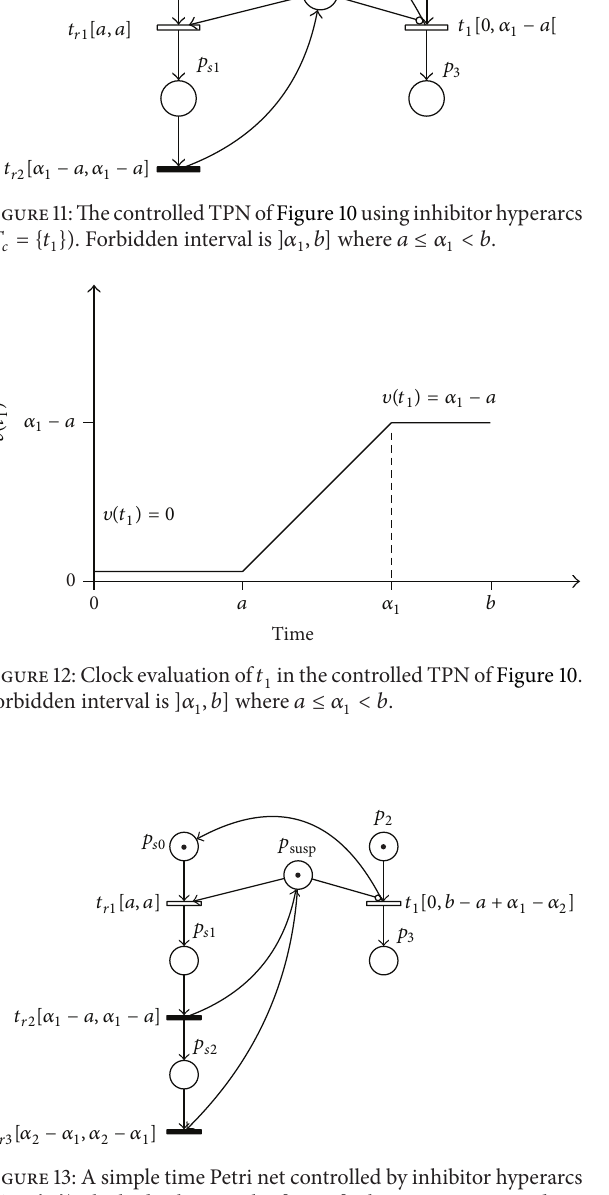
Figure 13: A simple time Petri net controlled by inhibitor hyperarcs ( 𝑇 𝑐 = {𝑡 1 }) ; the bad subinterval is [𝛼 1 , 𝛼 2 [ where 𝑎 < 𝛼 1 < 𝛼 2 ≤ 𝑏 .